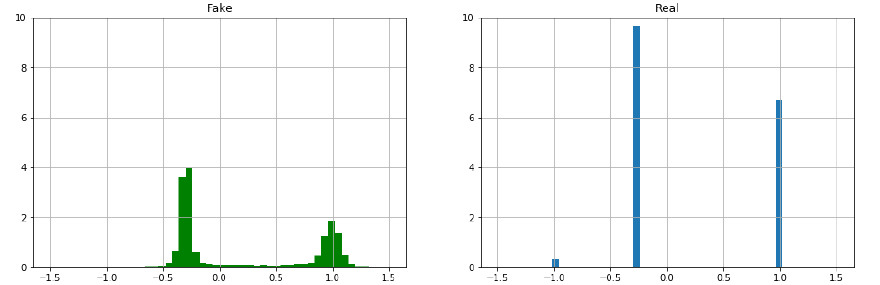
Figure 8. Distribution of the values for the ’Recorded_Status’ feature for the synthetic ( left ) and real ( right )